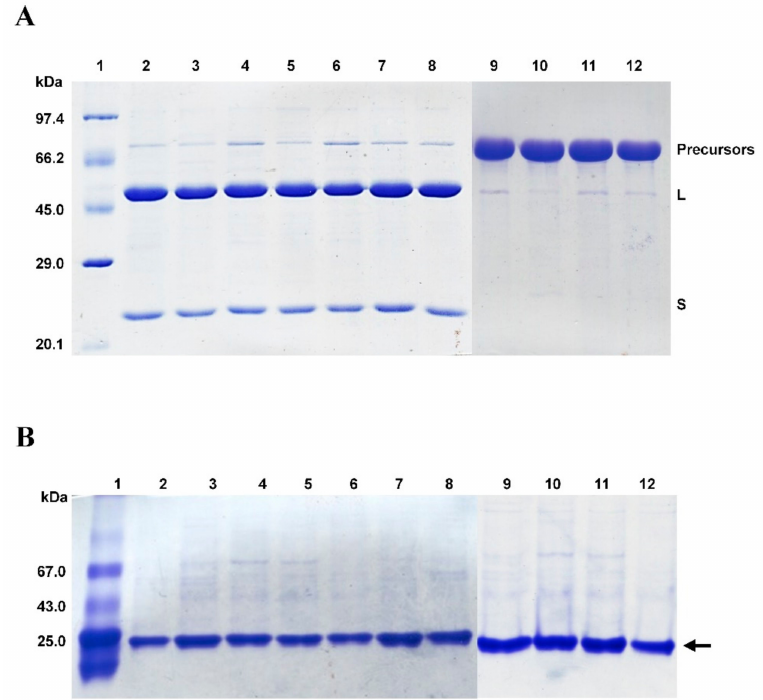
Figure 2. Polyacrylamide gel electrophoresis of the freshly prepared wild-type and mutant enzymes. ( A ) A representative analysis of the purified enzymes by 12% SDS-PAGE. Each lane was loaded with approximately 1.2 µ g of protein. The gels were stained with Coomassie Brilliant Blue R-250 solution and destained in a solution of 30% ( v / v ) methanol and 10% ( v / v ) acetic acid. Lanes 1–12 denote protein molecular weight marker, Bl GGT, P458A, L459A, S460A, S461A, M462A, P464A, ∆ M462, ∆ S460-M462, ∆ S461-M462, and ∆ P464, respectively. ( B ) Native gel electrophoresis of the purified enzymes. Each lane was loaded with approximately 0.6 µ g of protein and electrophoresis was performed in 1 × TG bu ff er (GMbiolab Co. Ltd., Taipei, Taiwan) at room temperature for 40 min using a constant voltage of 100 V. Gels were stained and destained as described above. The arrow indicates the position of major band. Albumin (67 kDa), ovalbumin (43 kDa), and chymotrypsinogen A (25 kDa) were used as reference standards. Table 1. The processing rate and specific activity of the freshly prepared wild-type and mutant enzymes.